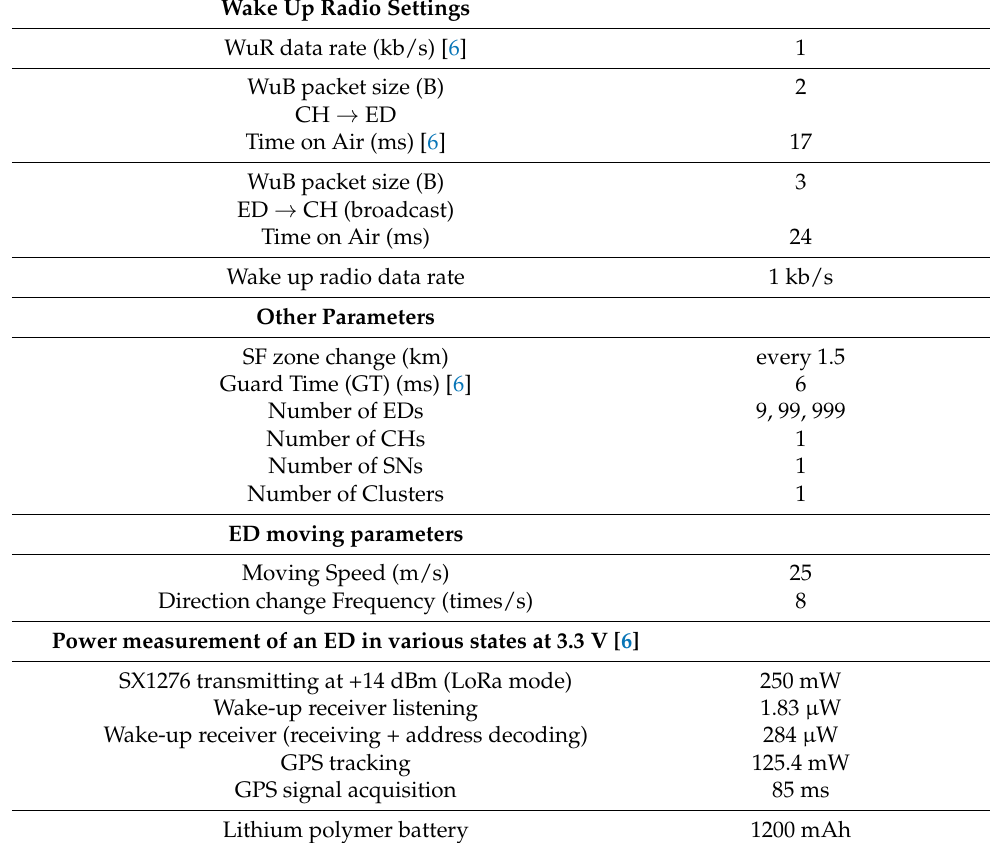
Table 3. Variables and